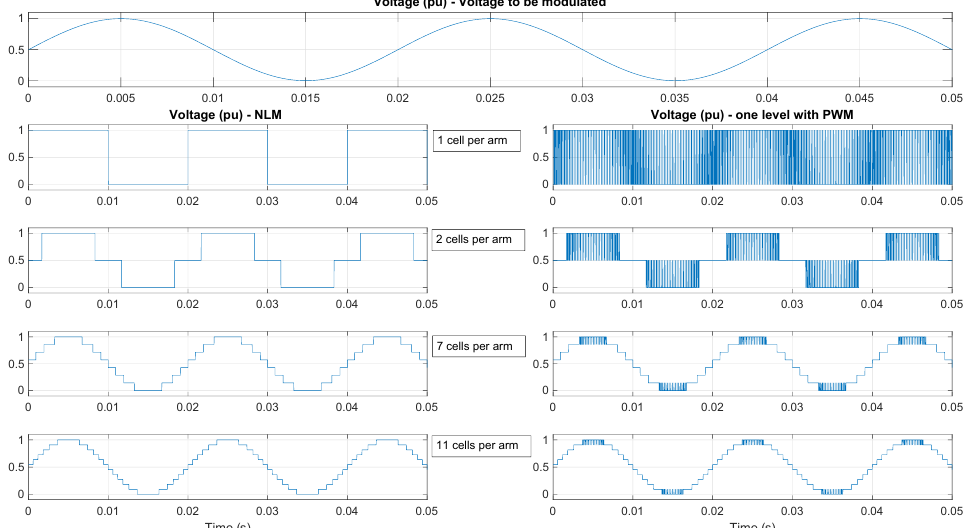
Figure 2. Example of NLM modulation and hybrid NLM-PWN modulation (PWM in only one cell per